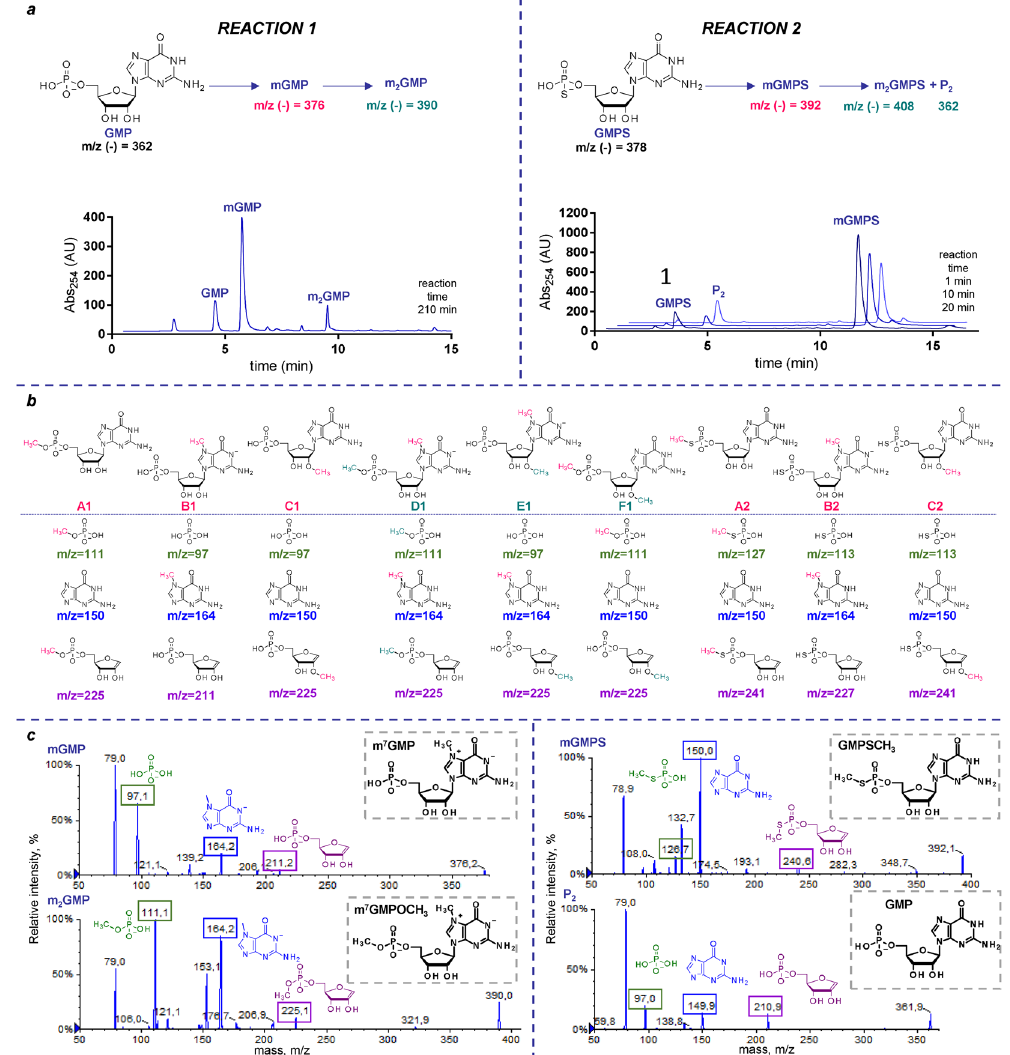
Figure 7. ESI( − )/MS/MS analysis of guanine nucleotide methylation products. ( a ) Scheme of the investigated reactions and representative RP HPLC chromatograms. ( b ) Possible reaction products and predicted fragments expected to be found in ESI( − )/MS/MS spectra for each of them. ( c ) Actual ESI( − )/MS/MS spectra and proposed structures of the products. The structures were independently confirmed by 1 H and 31 P NMR (Figs S10 and